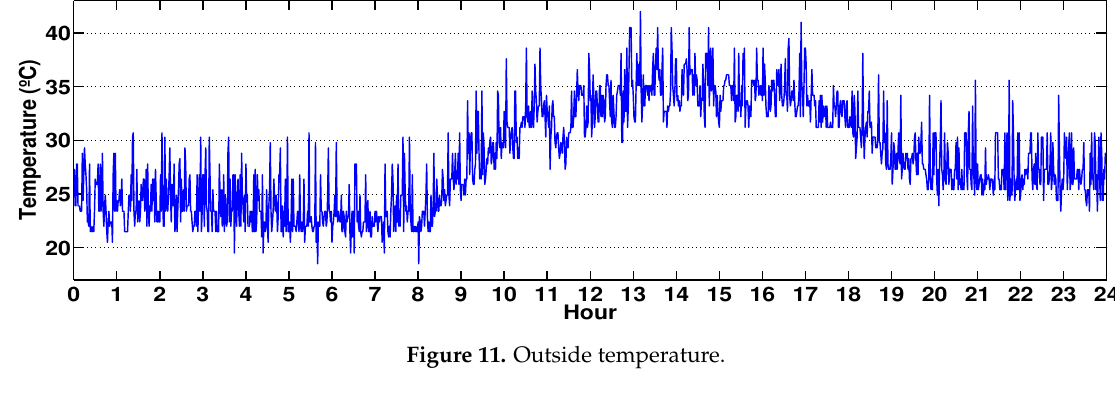
Figure 11. Outside temperature.